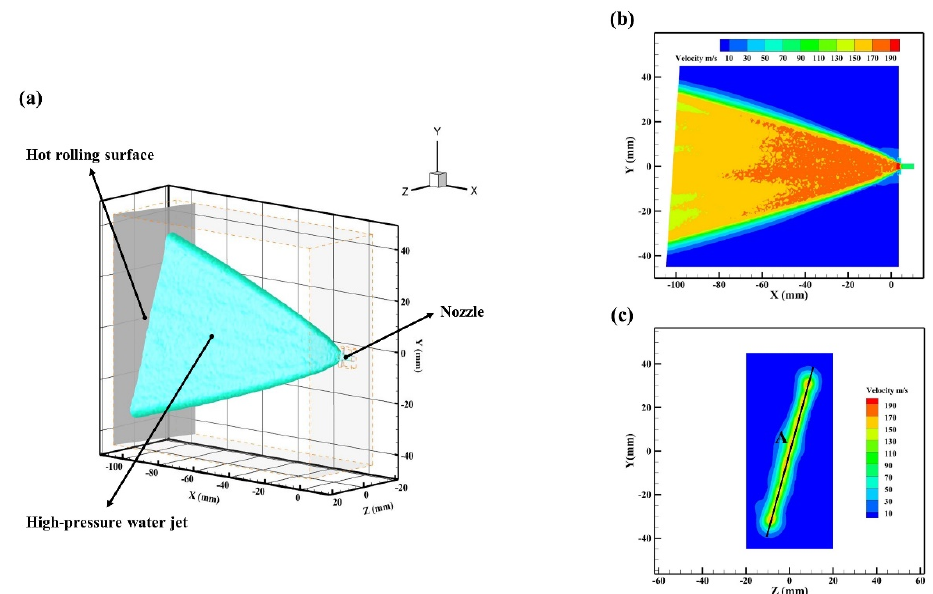
Figure 7. A schematic diagram of simulation results for the hot rolling. ( a ) Iso-surface view of the high-pressure water jet; ( b ) Cross-sectional view of the high-pressure water jet; ( c ) Cross-sectional view of the hot rolling surface.